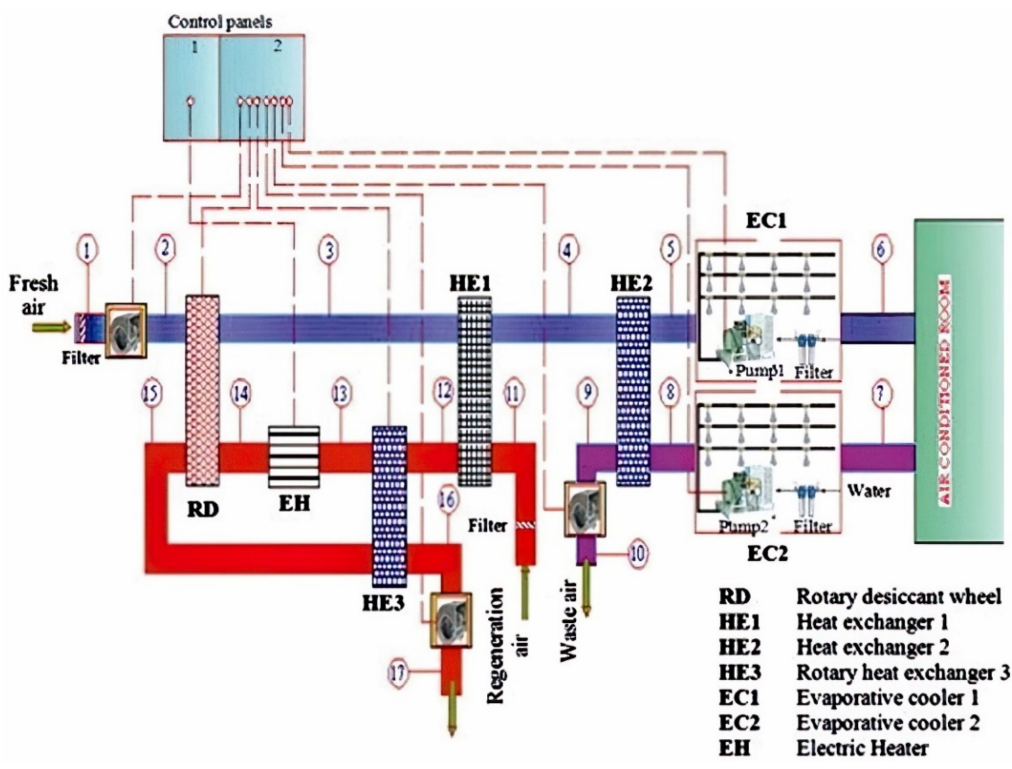
Figure 5. Configuration of desiccant-based ECT system [72].